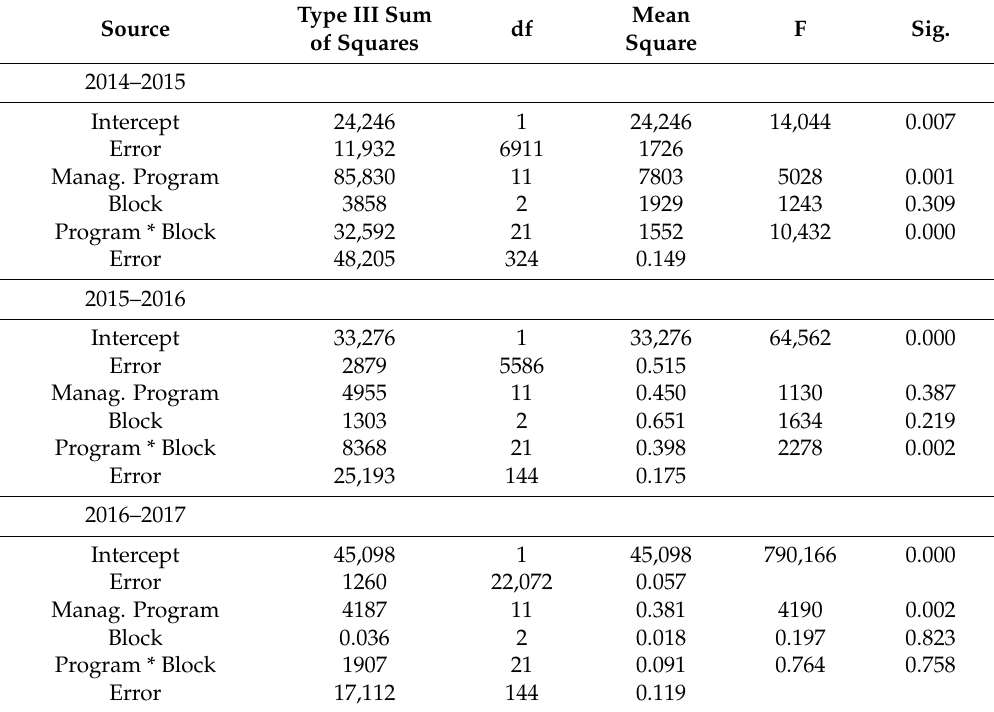
Table 5. Results of the ANCOVA applied to the final densities of B. diandrus in each season. df, degrees of freedom; F, F test of Fisher; Sig.,